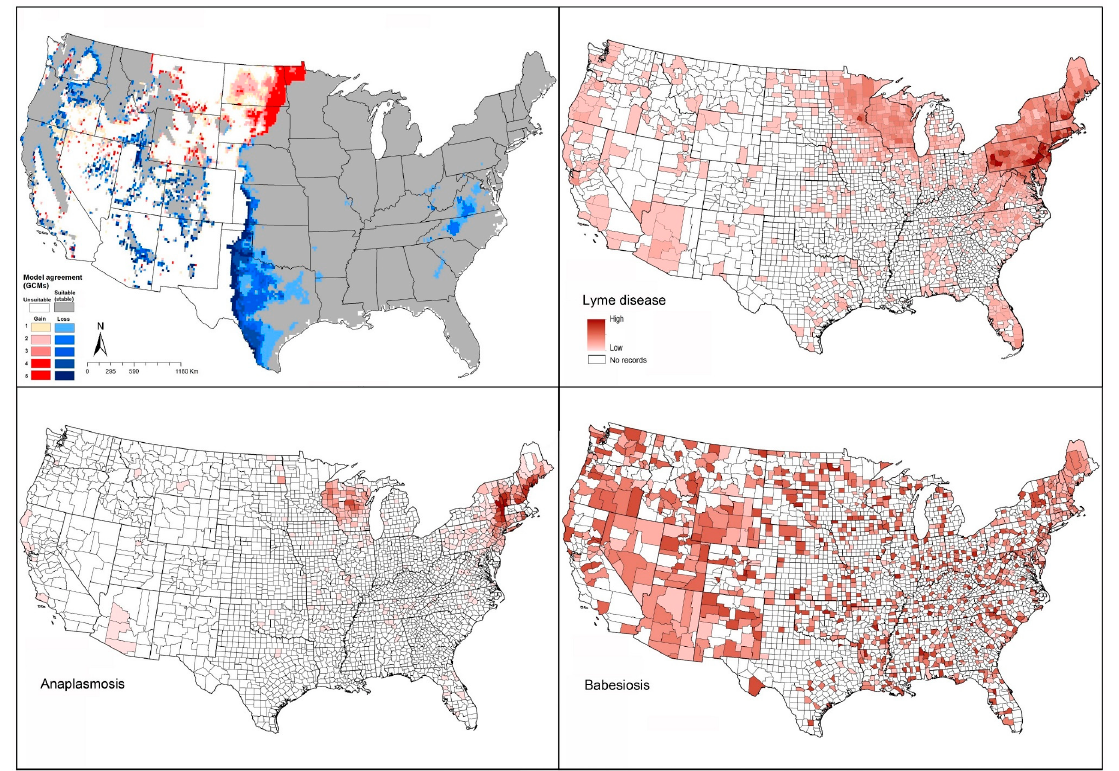
Figure 3. Geographic distribution of Ixodes scapularis and diseases that it is suspected to transmit in the United States. Dark pink represents high incidence, light pink indicates low incidence. White represents no records.